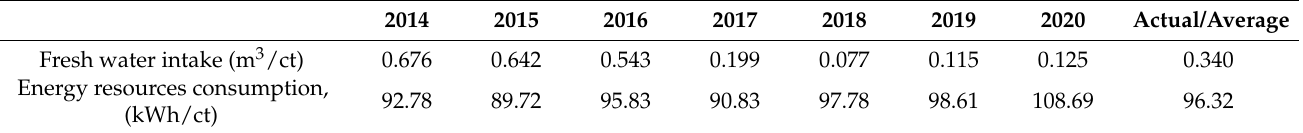
Table 1. The water and energy consumption of diamond mining over 7 years, for the ALROSA GROUP [17–19].